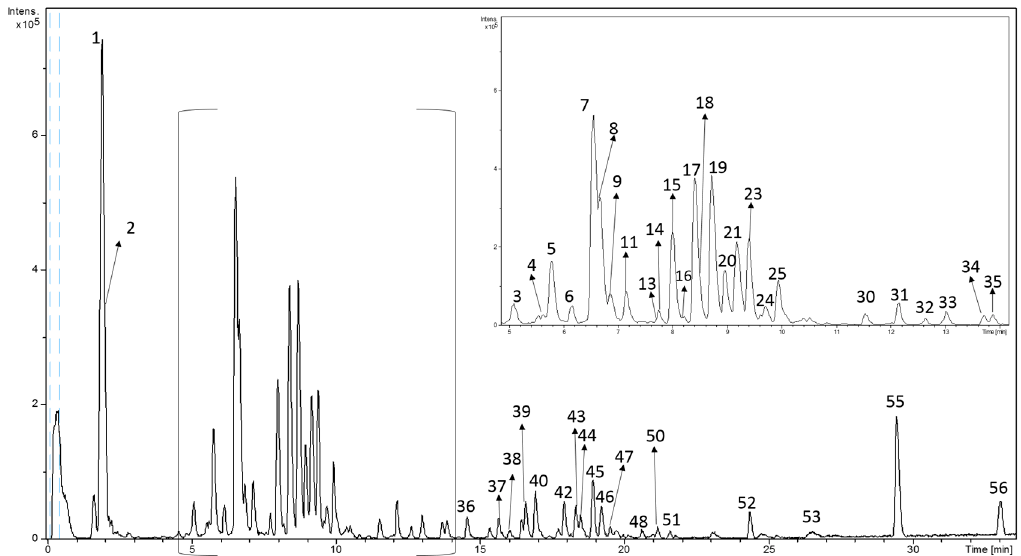
Figure 1. Characterization of extracted compounds of Morus Alba leaves using reverse phase high performance liquid chromatography–electrospray ionization-time of flight-mass spectrometry (RP-HPLC-ESI-TOF-MS).